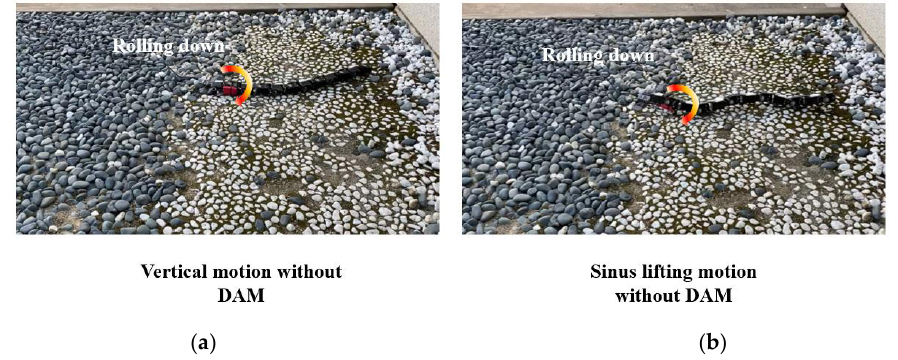
Figure 25. Performance of the robustness without the DAM on the gravelly field. ( a ) The vertical motion with DAM in the gravelly field. ( b ) The sinus lifting motion with DAM in the gravelly